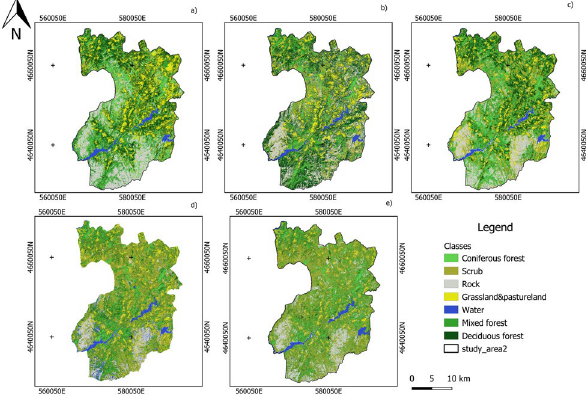
Figure 5. Land use classification maps (a) 2016-year; (b)